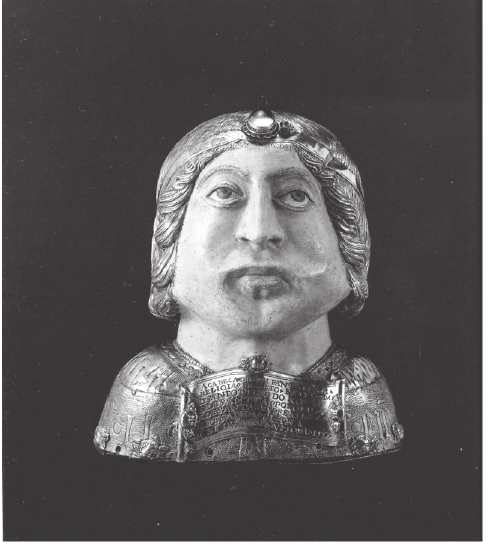
Figure 4: Reliquary of São